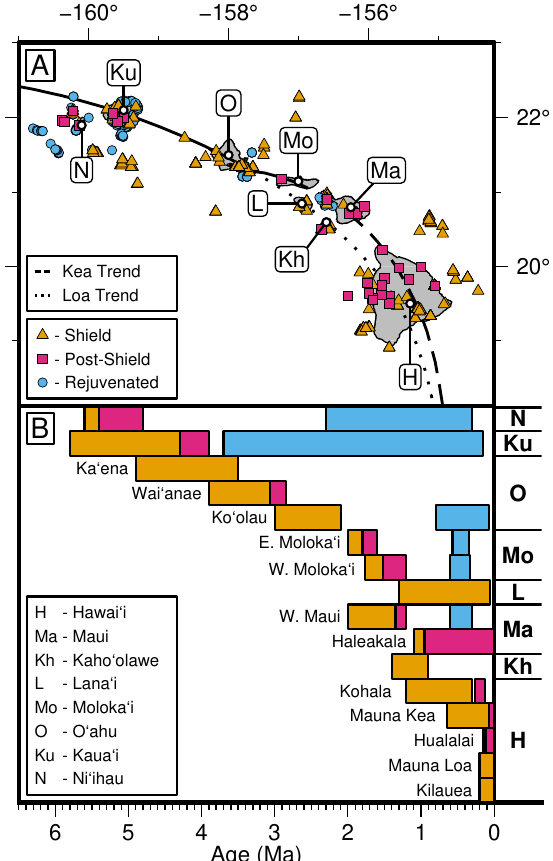
Figure 3: Location and stratigraphy of the Hawaiian is- lands. [A] Map with Hawaiian islands in gray, letters indicate island names as described in lower left of fig- ure. Orange/pink/blue symbols = basaltic samples from shield/post-shield/rejuvenated phases of volcanism used for thermobarometric analysis. Solid/dashed/dotted lines = com- bined/Kea/Loa volcanic tracks [taken from Jones et al. 2017]. [B] Stratigraphic lexicon of Hawaiian islands and their vol- canoes [as denoted by letters along the right-hand side and names listed on the left-hand side, respectively; Clague and Frey 1982; Cousens and Clague 2015; Sinton et al. 2017]. Bar color = phase of